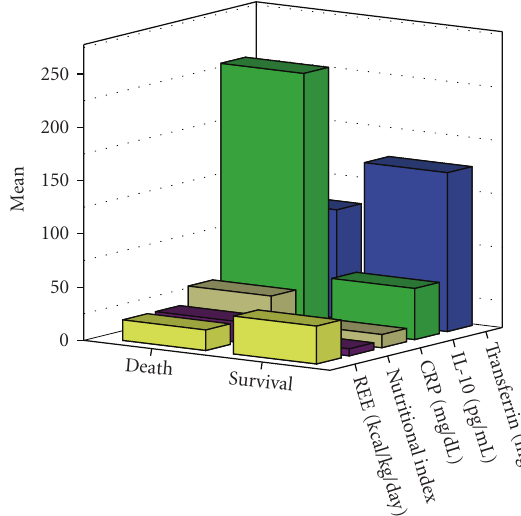
Figure 7: Opposite trends of C-Reactive Protein (CRP), Inter- leukin-10 (IL-10), and nutritional index compared to transferrin, and Resting Energy Expenditure (REE) were recorded between survivors and